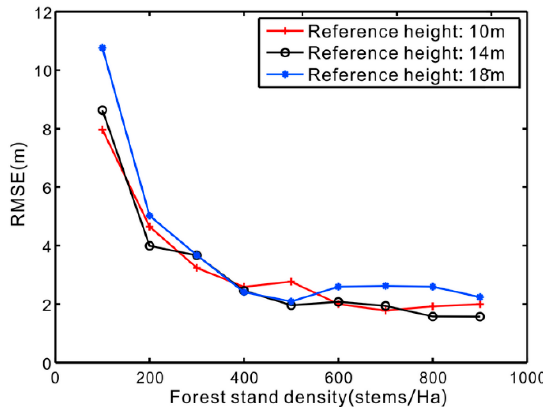
Figure 2. The RMSE of inversed height for different forest stand density from the simulated data with reference height of 10 m (line with plus), 14 m (line with circle), and 18 m (line with asterisk).